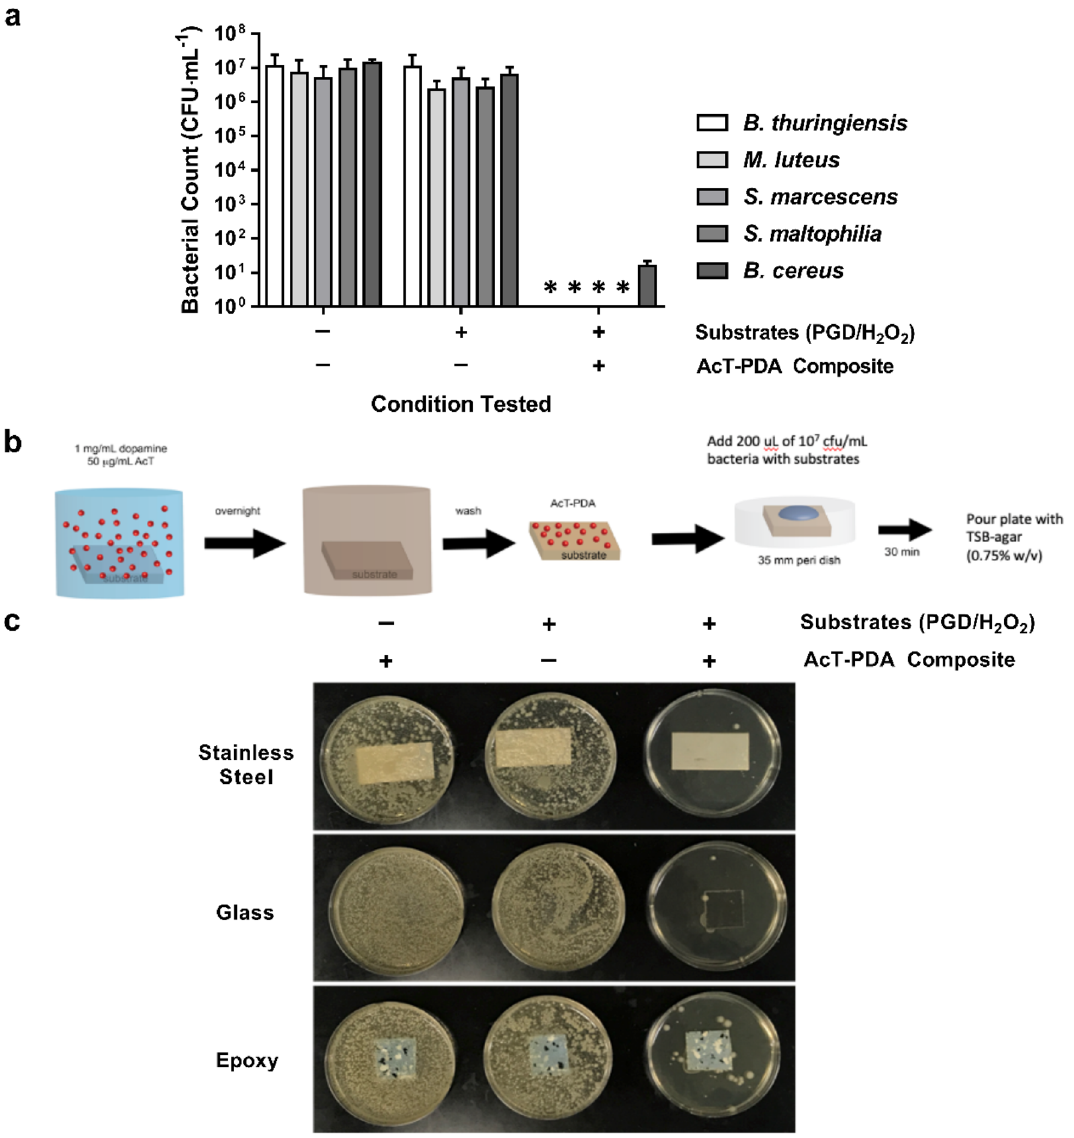
Figure 4. Antimicrobial activity of AcT-PDA against different bacterial strains. ( a ) Broad-spectrum antimicrobial activity observed for AcT-PDA composites (50 μg AcT mg −1 PDA) on polystyrene against all bacteria challenged as determined by reduction in CFU through conversion of PGD/H 2 O 2 into PAA. Four of five bacteria challenged resulted in no CFU being observed and are indicated by asterisks. All tests of coating activity were performed with n = 2 replicates and results are shown as mean ± standard deviation. ( b ) Diagram showing method for making AcT-PDA coatings (50 μg AcT mg −1 PDA) and demonstrating their self- decontaminating capabilities on various surfaces when presented with a microbial challenge (200 μL at 10 7 CFU mL −1 ). ( c ) Pictures demonstrating killing effectiveness of AcT-PDA coatings on glass, stainless steel, and epoxy against B. cereus using method in ( b ) when microbial challenge was added to bare or AcT-PDA coated surfaces and incubated for 30 min with or without substrates (10 mM PGD and 1 mM H 2 O 2